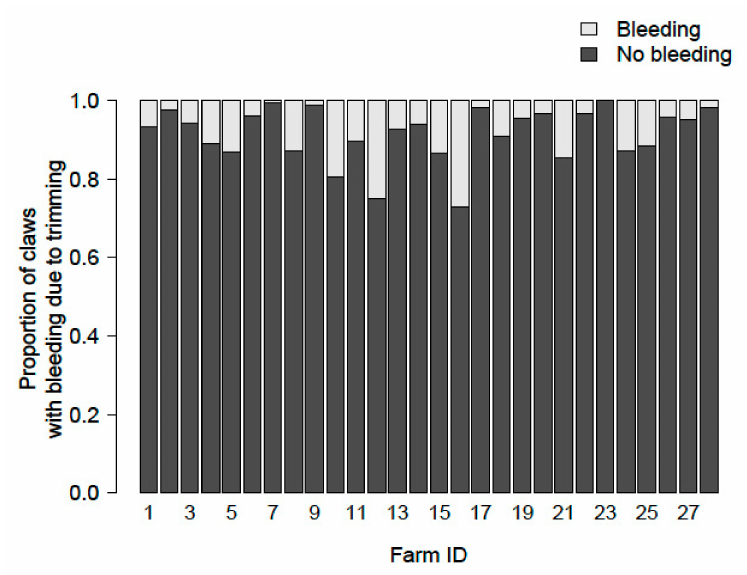
Figure 8. Distribution of claws with bleeding due to trimming on the 28 farms.